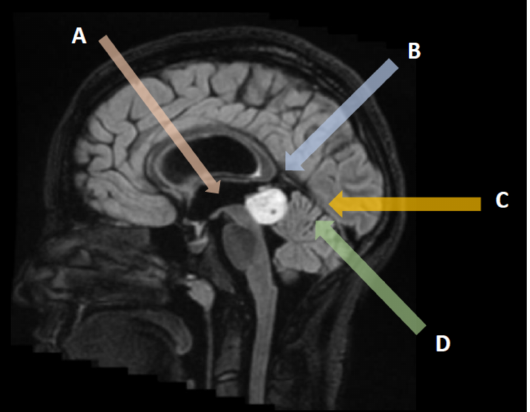
Figure 2. Surgical approaches to pineal region tumors: Endoscopic transventricular third ventriculostomy and biopsy with CSF sampling ( A ), interhemispheric parietal approach ( B ), suboccipital transtentorial approach ( C ), and supracerebellar infratentorial approach ( D ).